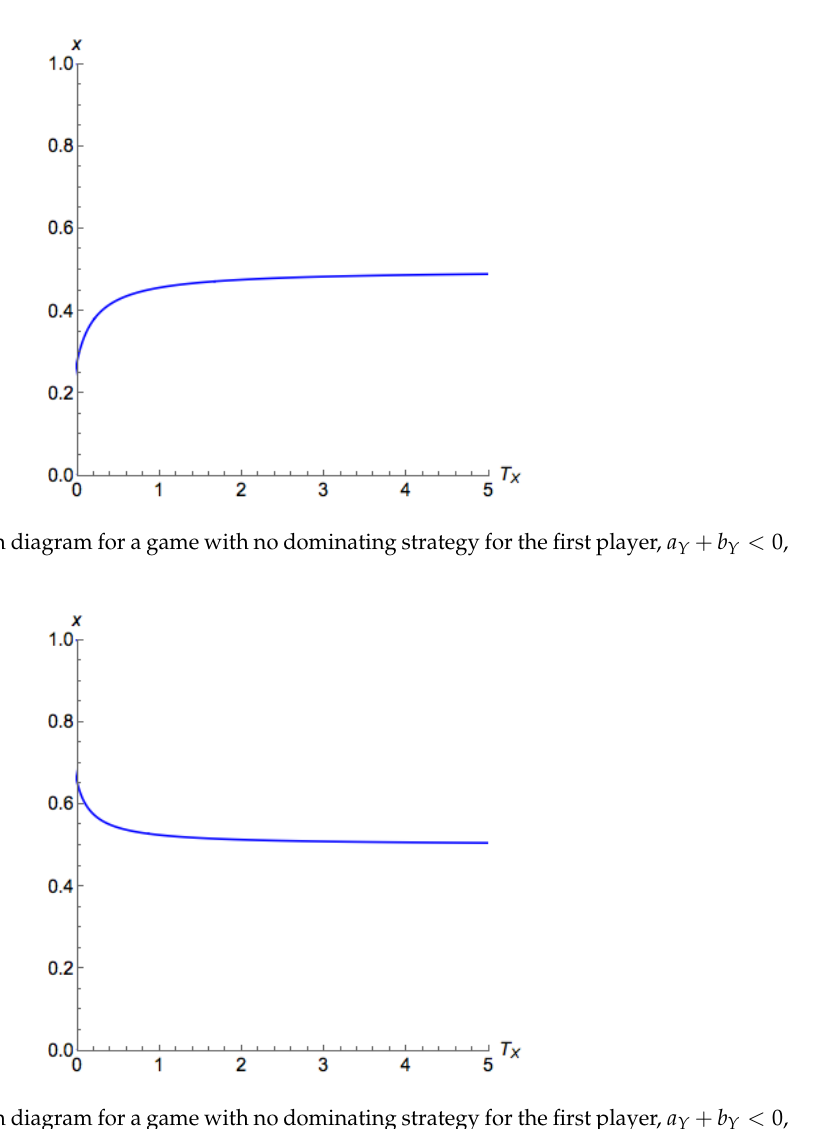
Figure A2. Bifurcation diagram for a game with no dominating strategy for the first player, a Y + b Y < 0, and a high T Y